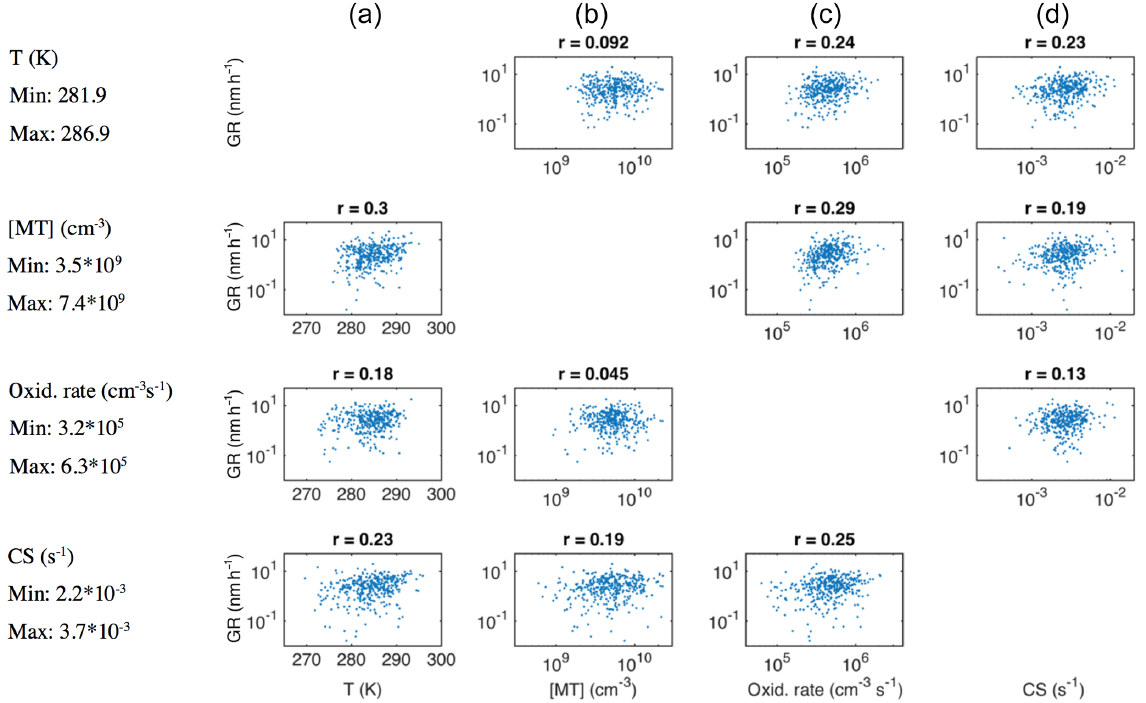
Figure 8. Growth rate of growth periods with duration >2h and starting size 50nm< d P <60nm during April–September depicted as a function of temperature (a) , monoterpene concentration (b) , monoterpene oxidation rate (c) and condensation sink (d) , while one of these four variables is limited to vary between its 30th and 70th percentile (limited variable for each row and the percentile values indicated on the left-hand